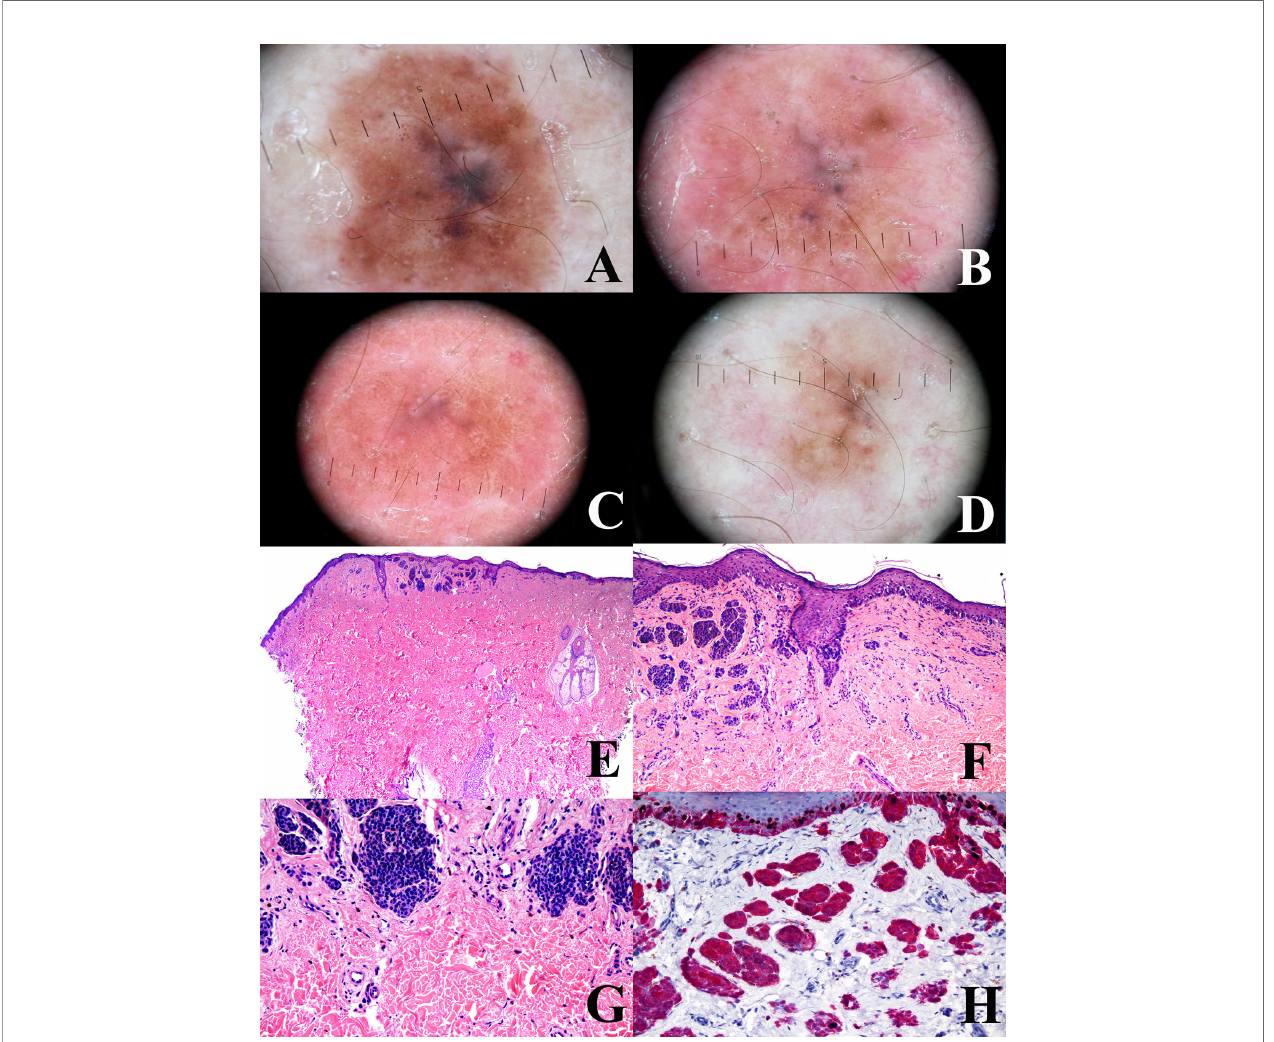
after 1 year (B) , four years (C) , and 6 years (D) . The tumor discloses a “ trizonal ” histopathological pattern ( E ; hematoxylin – eosin, ×25), with an atypical junctional component, a scar-like dermal thickening ( F ; hematoxylin – eosin, ×100) and a very bland-appearing deep dermal component ( G ; hematoxylin – eosin, ×100); the proliferation rate (Ki67-positive dermal melanocytes, evaluated with a KI67/MART1 double stain) is very low ( H ; ×250). These histopathological features are consistent with the so-called “ sclerosing nevus with pseudomelanomatus features ” . Such a histopathological diagnosis is in keeping with the slowly progressive and relatively symmetrical involution of the tumor, as documented with dermoscopic digital monitoring. Clinical images provided by Dr. Luigi Ligrone, Salerno,